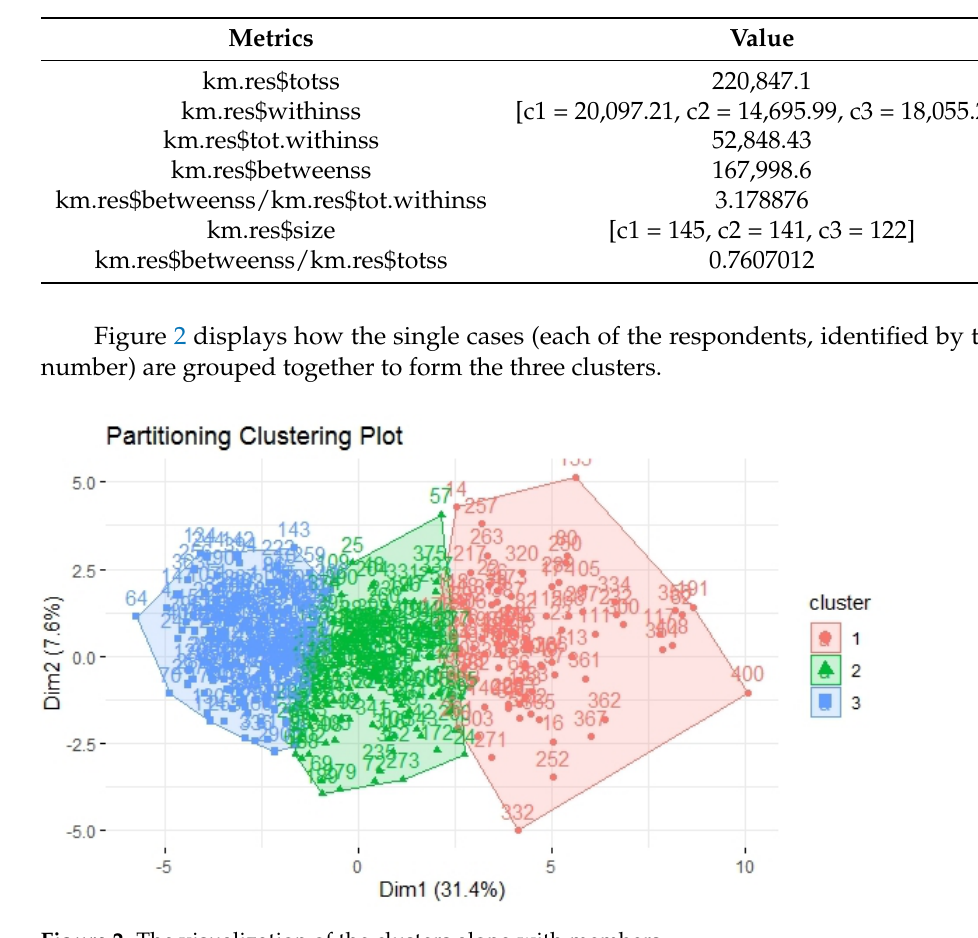
Figure 1. The optimal number of clusters. Table 1. Measures of cluster fitness.